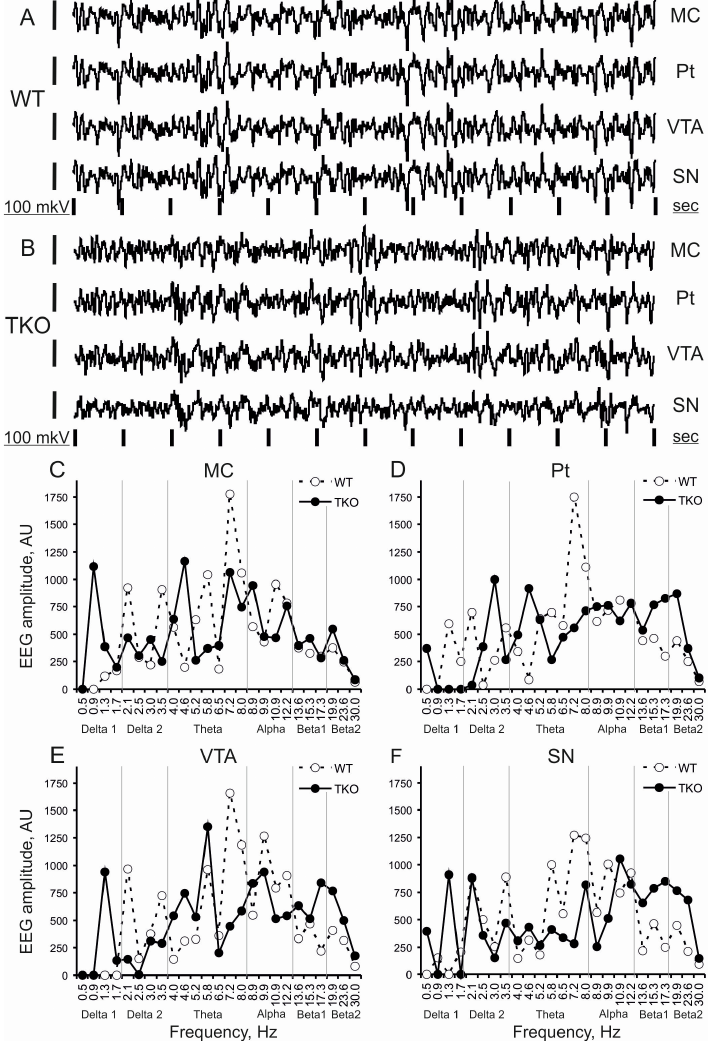
Figure 1. Baseline EEG fragments and their frequency spectra in a 3-month-old triple-knockout mouse vs a wild-type littermate. Typical patterns in 12 s fragments of baseline EEG in wakeful and behaviourally active wild-type (WT) and triple ( alpha-, beta-, and gamma- synucleins) knockout (TKO) mice (( A ) and ( B ), respectively) and their frequency spectra ( C – F ) in the motor cortex (MC), puta- men (Pt), ventral tegmental area (VTA) and substantia nigra (SN). On A and B, time calibration is 1 sec and amplitude calibration is 100 µV. On ( C – F ), abscissa is a frequency sub-band marked with its mean value, in hertz ordinate is the summed amplitudes of EEG in each of the 25 sub-bands, nor- malised to a sum of all amplitude values, in arbitrary units. Vertical grey lines separate “classical” EEG frequency bands: delta 1 , delta 2, theta , alpha , beta 1 , and beta 2 .